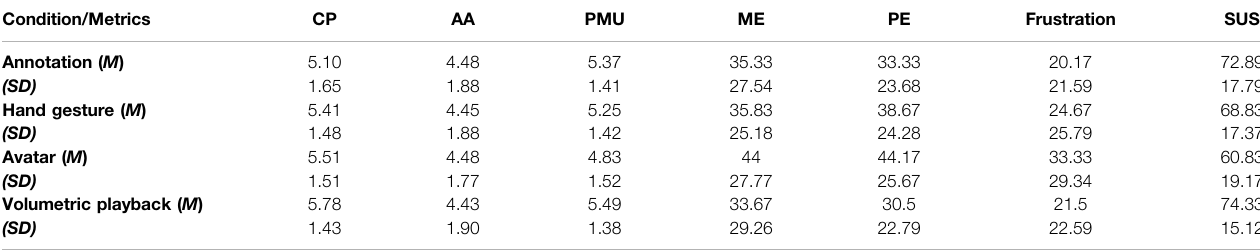
TABLE 1 | Questionnaires results of social presence and Workload.Co-Presence (CP), Attention Allocation (AA), Perceived Message Understanding (PMU), Mental Effort (ME), Physical Effort (PE), Frustration and System Usability (SUS). Condition/Metrics